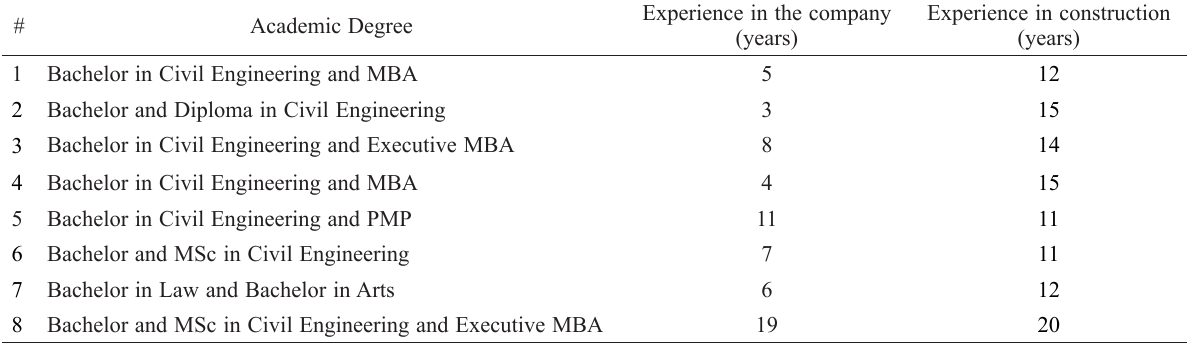
# Academic Degree